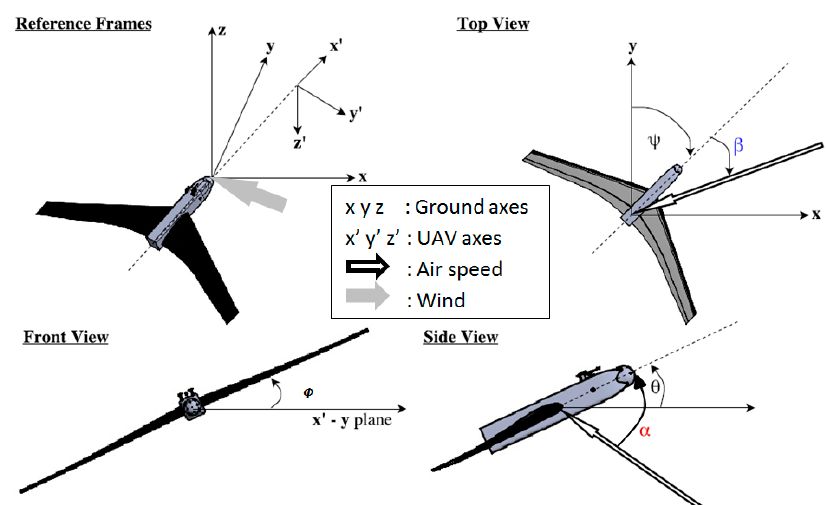
Figure 2. The earth and airplane coordinate systems were used for calculating the air velocity with respect to the earth referential. (x, y, z): earth coordinate system (i.e., east, north, upward); (x’, y’, z’): UAV coordinate system. The curved arrows indicate positive angles (see the text for angle definitions). Adapted from Reference [3].